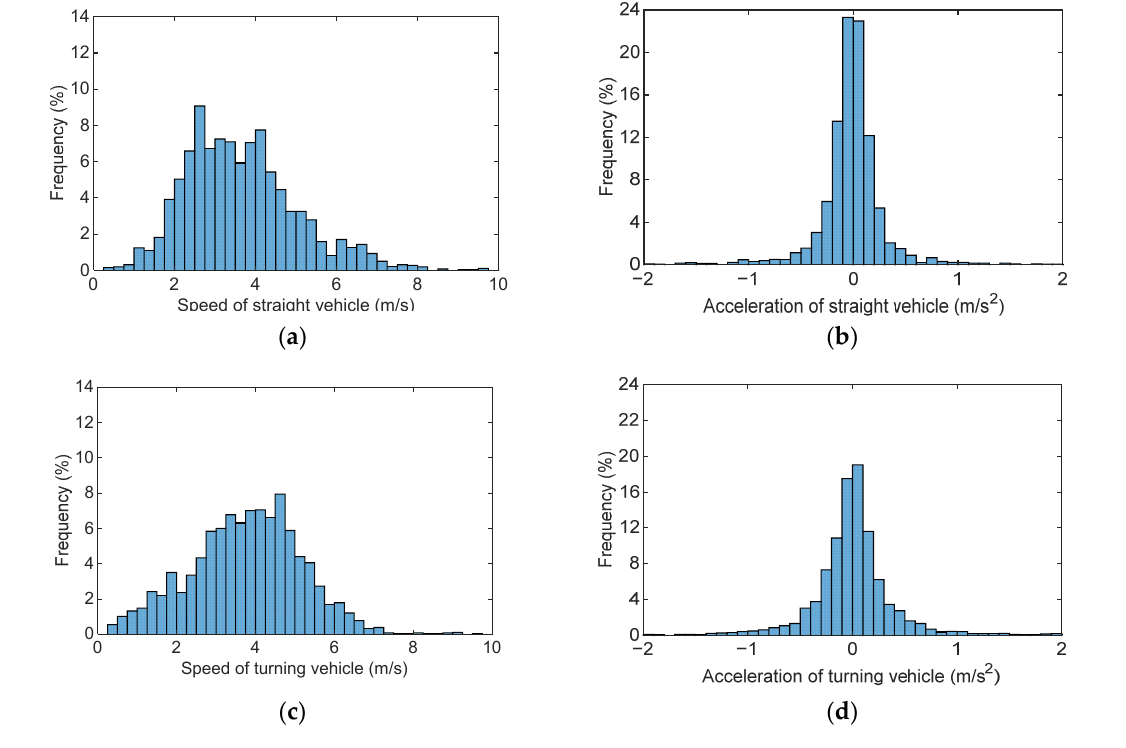
Figure 9. Statistical-distribution histogram of track information when the straight vehicle gives way: ( a ) speed of straight vehicle, ( b ) acceleration of straight vehicle, ( c ) speed of turning vehicle, and ( d ) acceleration of turning vehicle.